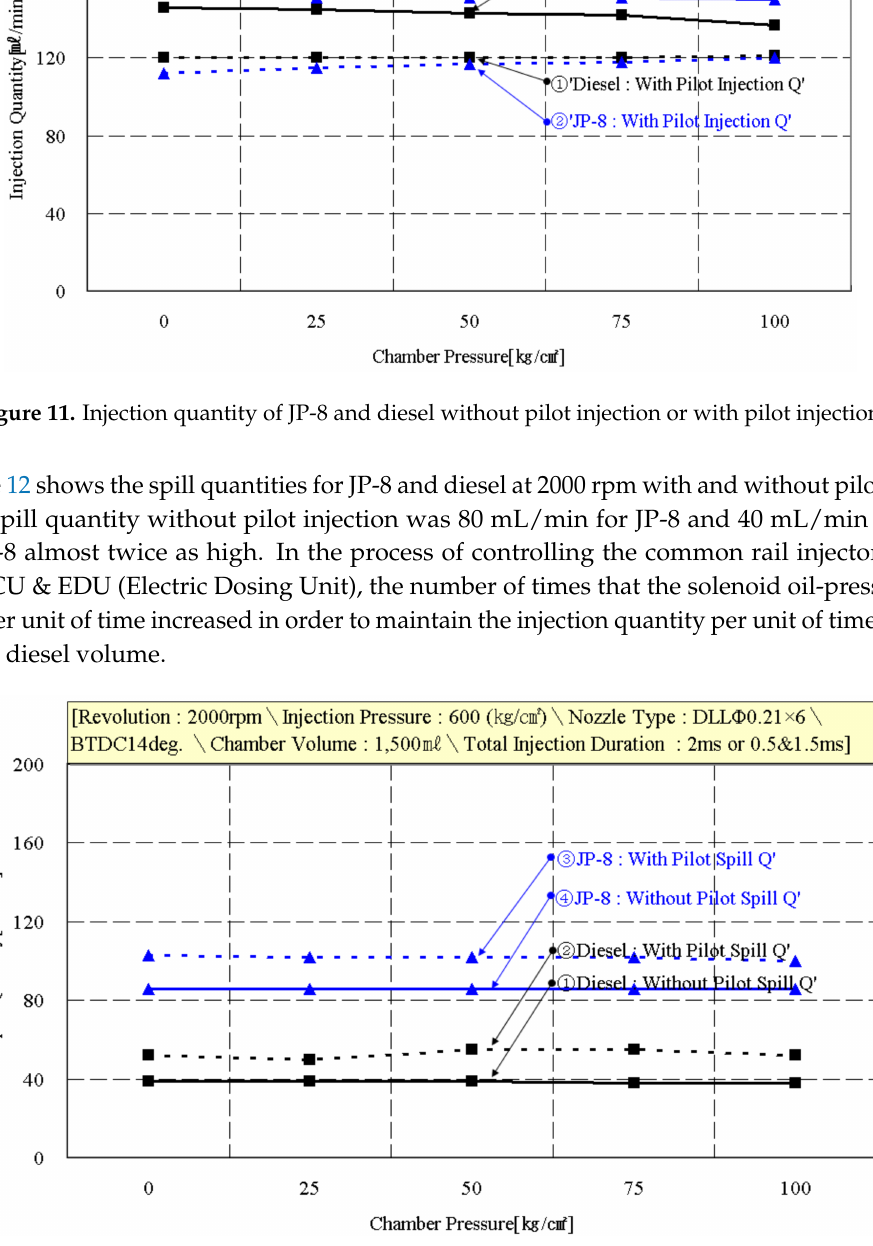
Figure 12. Spill quantity of JP-8 and diesel without pilot injection or with pilot